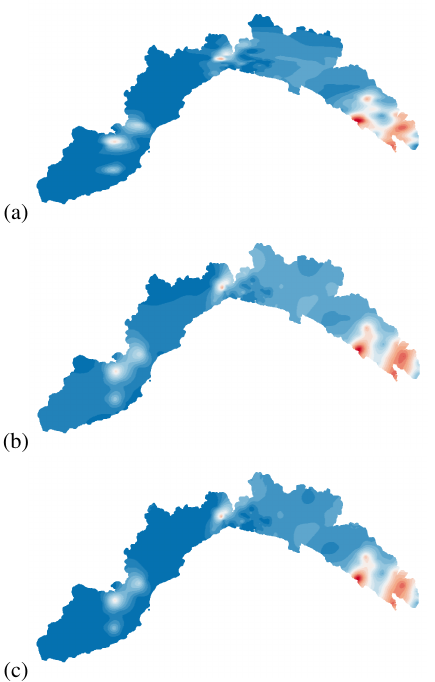
Figure 2: Rainfall fields computed for the event of September, 23: (a) LR B-Spline, (b) RBF, (c) Kriging. be in the magnitude of ( d 1 + 1) × ( d 2 + 1) where d 1 and d 2 are the polynomial degrees in the two parameter directions of the sur- face. The surface is bi-quadratic so d 1 = d 2 = 2 . In our tests, the algorithm is run with 20 iterations giving a total of 3 × 20 × N × 9 bi-variate B-spline evaluations.